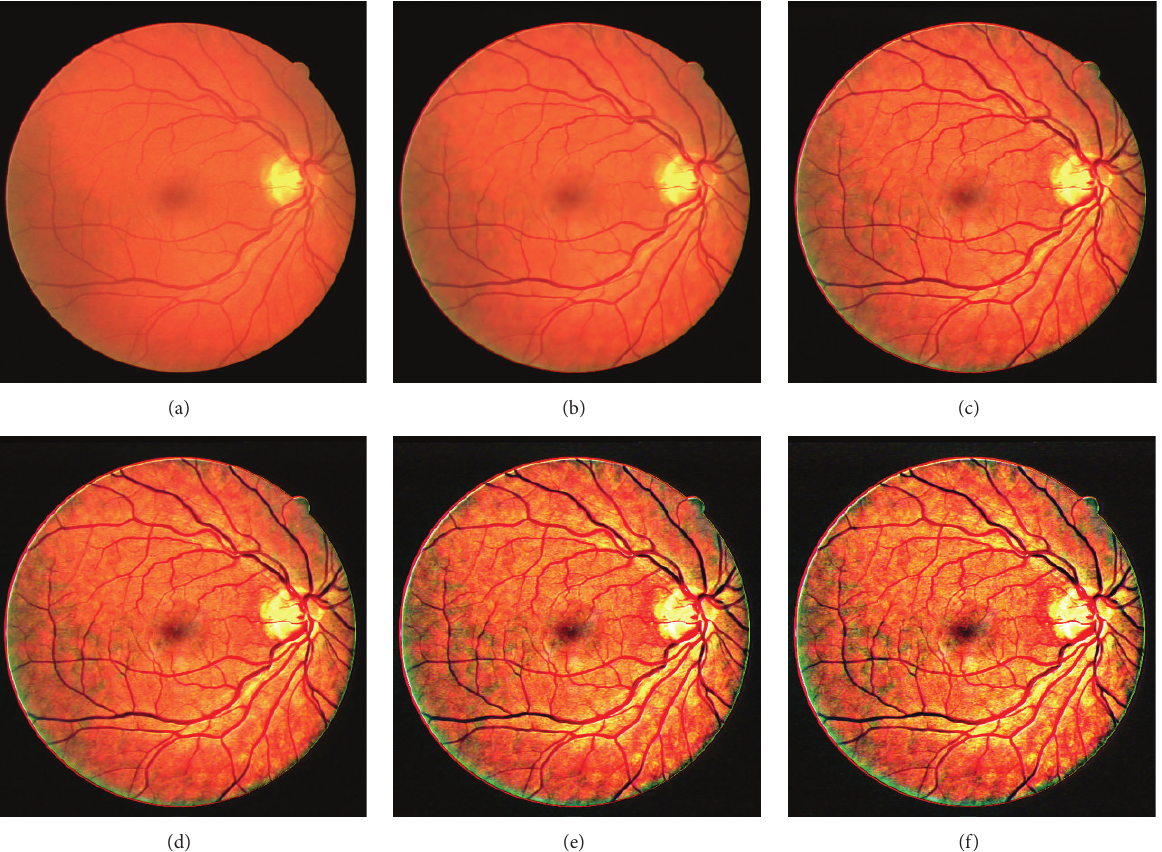
Figure 2: The enhancement results of the retinal image with different 𝑎 . (a) Original image; (b) enhanced image with 𝑎 = 1 ; (c) enhanced image with 𝑎 = 3 ; (d) enhanced image with 𝑎 = 5 ; (e) enhanced image with 𝑎 = 8 ; (f) enhanced image with 𝑎 = 10